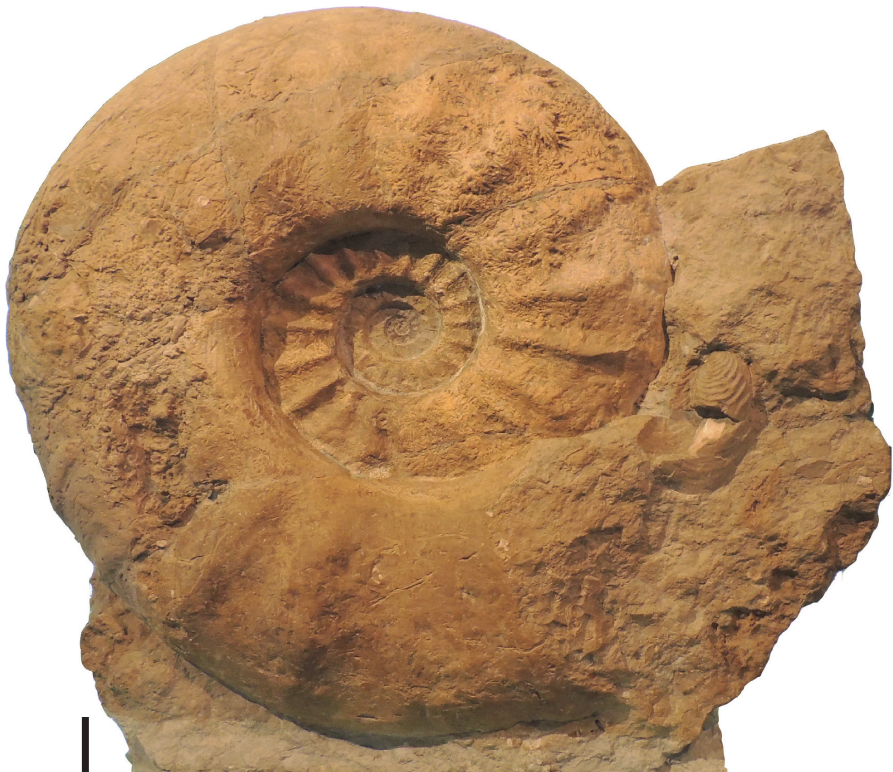
Fig 1. Lectotype of Parapuzosia ( P .) seppenradensis from Westfalia, Germany. The specimen was collected in 1894 near Seppenrade. LWL-Museum for Natural History, Mu¨nster. Photo: CI. Scale: 100 mm.